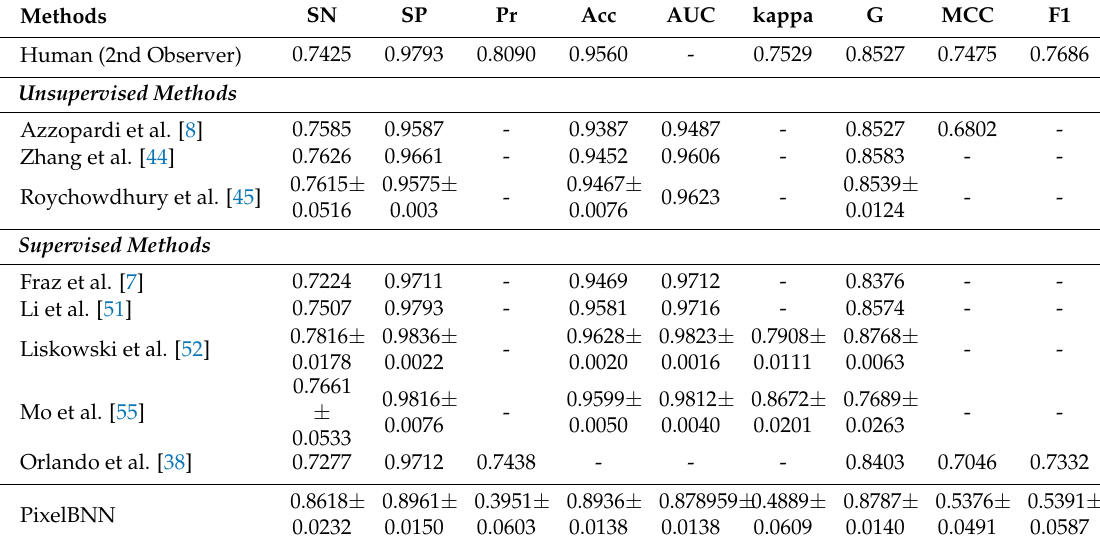
Table 5. Performance comparison for models trained and tested with